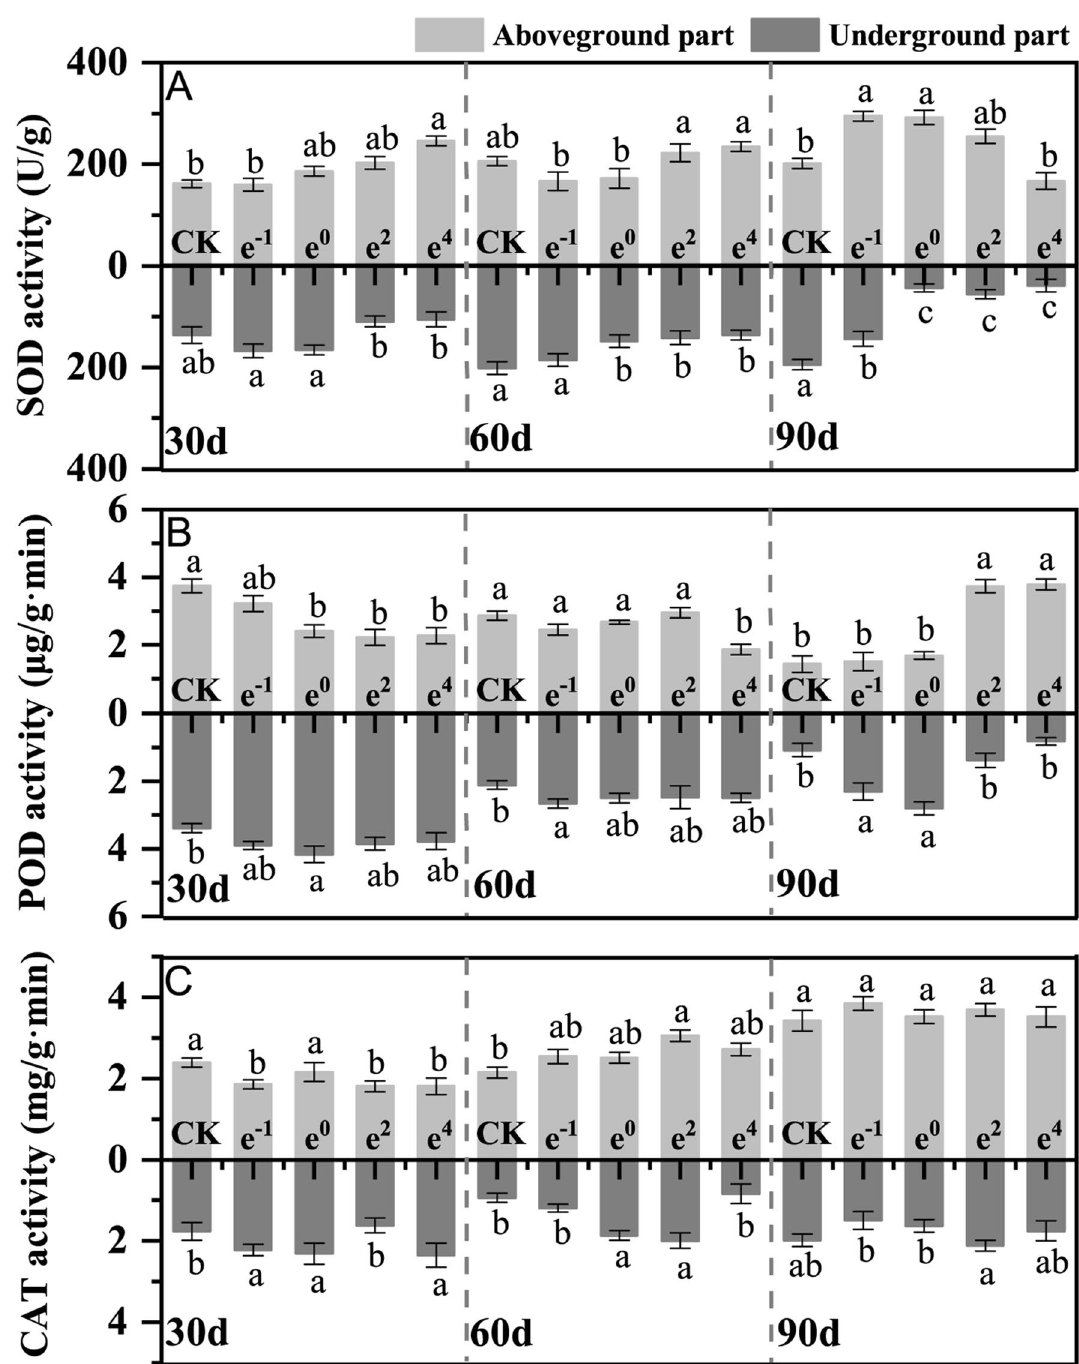
Figure 3. Antioxidant enzyme activity of Polygonatum sibiricum . ( A ) Superoxide dismutase (SOD) activity in the aboveground and underground parts; ( B ) Peroxidase (POD) activity in the aboveground and underground parts; ( C ) Catalase (CAT) activity in aboveground and underground parts. Each value represents the mean ± standard deviation of three independent experiments. Different letters above the bars represent significant differences ( p <